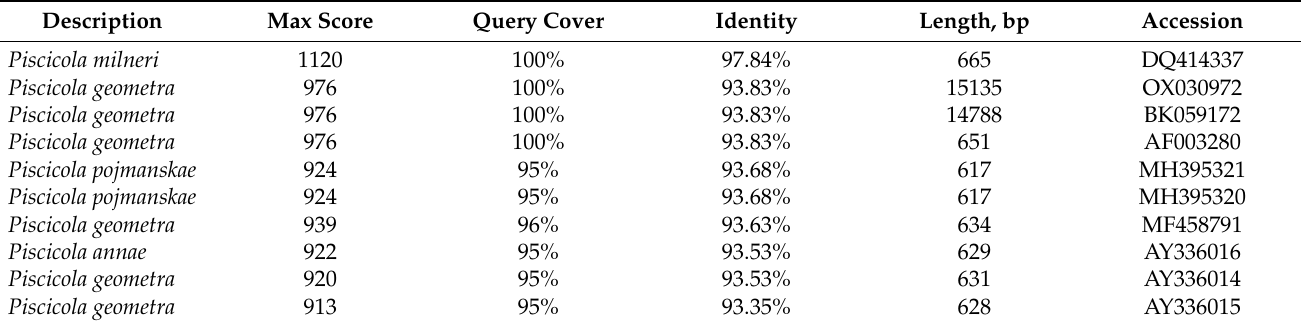
Table 2. Top 10 Piscicolidae homologous sequences selected using BLAST with the statistical signifi- cance of the